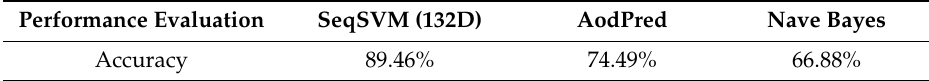
Table 1. The comparison of accuracy with existing